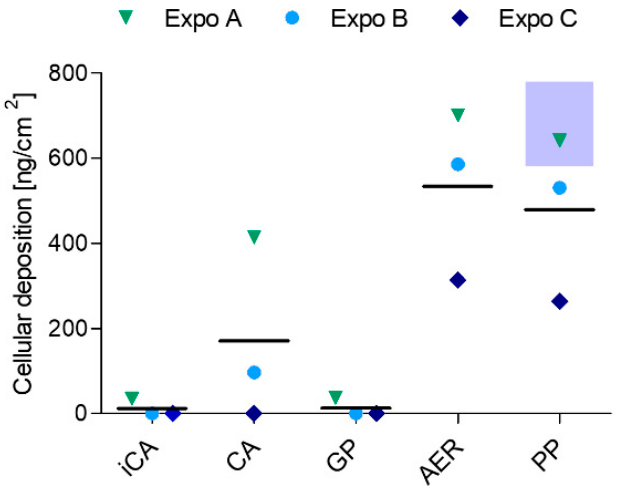
Figure 3. Liquid chromatography tandem mass spectrometry measurements of DBP deposition [ng/cm 2 ] on the ALI cell layer upon exposure to the different SVOC phases of DBP in three inde- pendent exposures (Expos A, B, C). The blue shaded area represents the deposition range of the model calculations of DBP particles. iCA = independent clean air, CA = clean air, GP = gas phase, AER = aerosol, PP = particle phase.